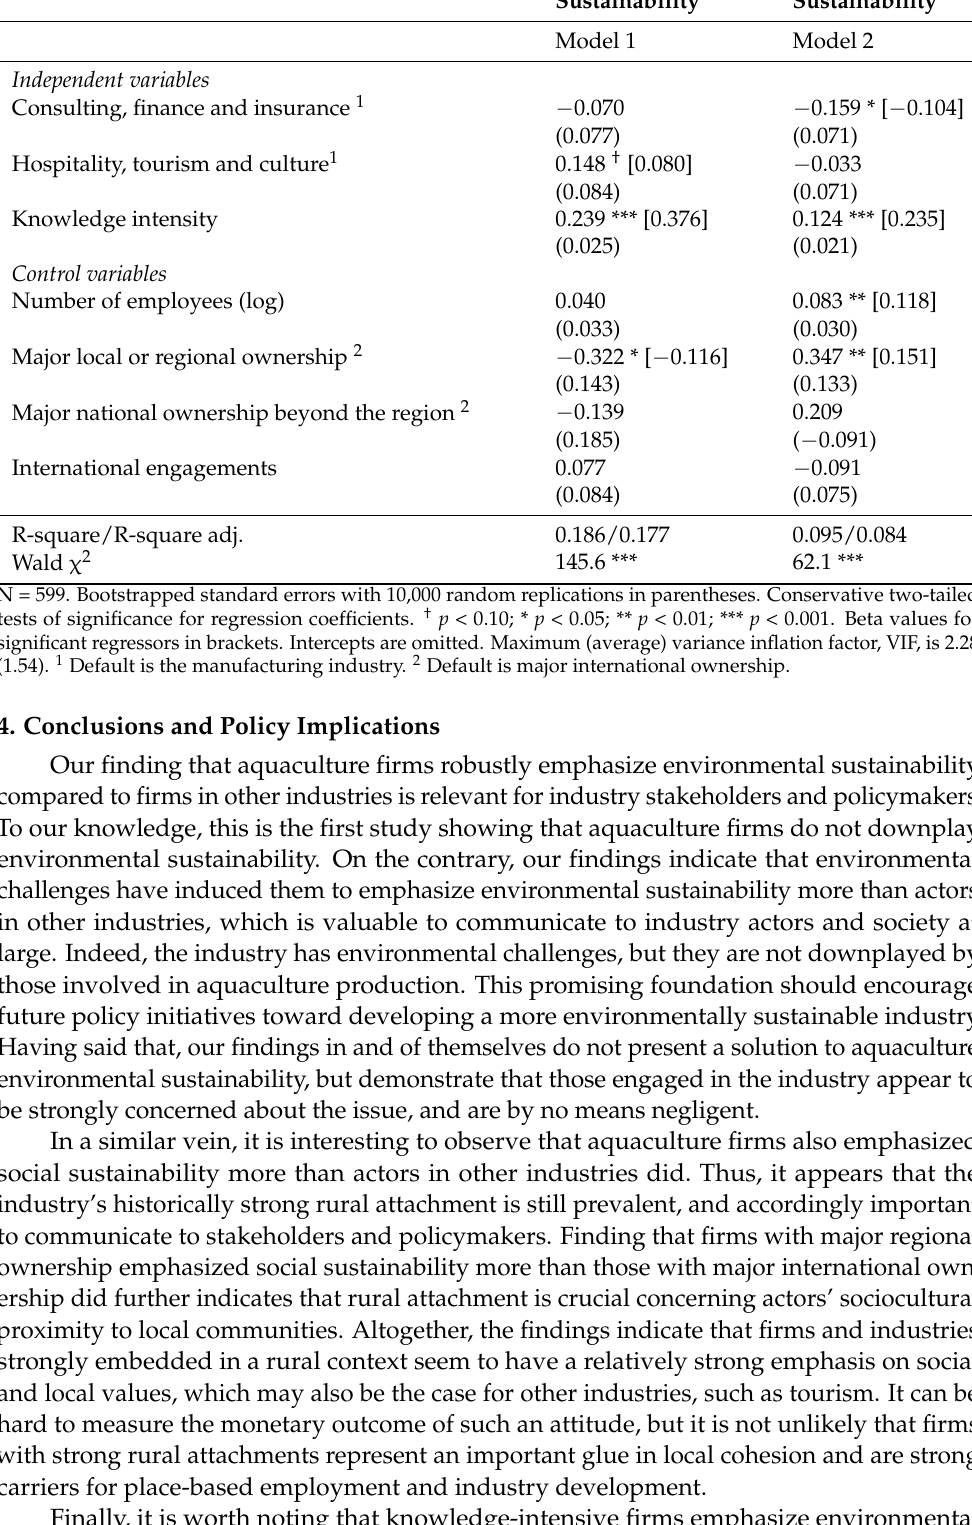
Table 4. Bootstrapped ordinary least square (OLS) regressions excluding the aquaculture industry. Dependent